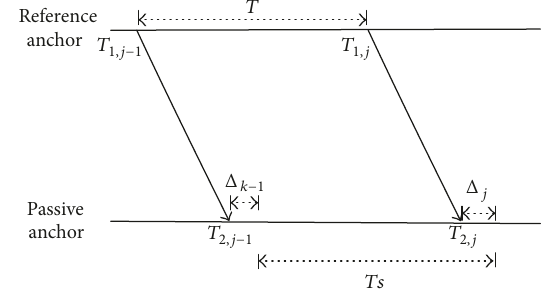
Figure 2: Space-time of reference-passive anchors.